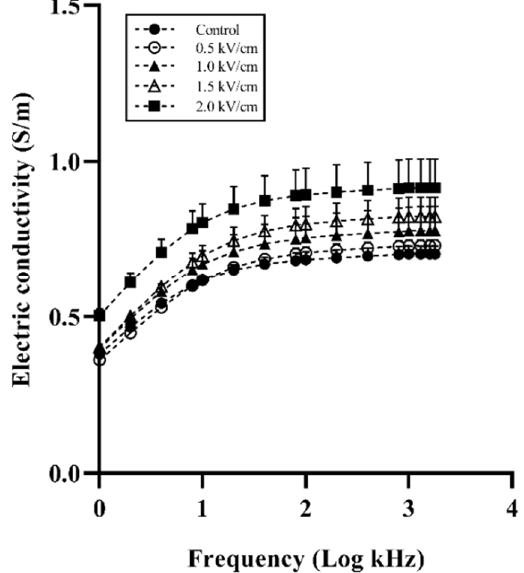
Figure 2. Electrical conductivity spectra of beef with different field strengths. Error bars indicate the standard deviation of six replications ( n = 6).